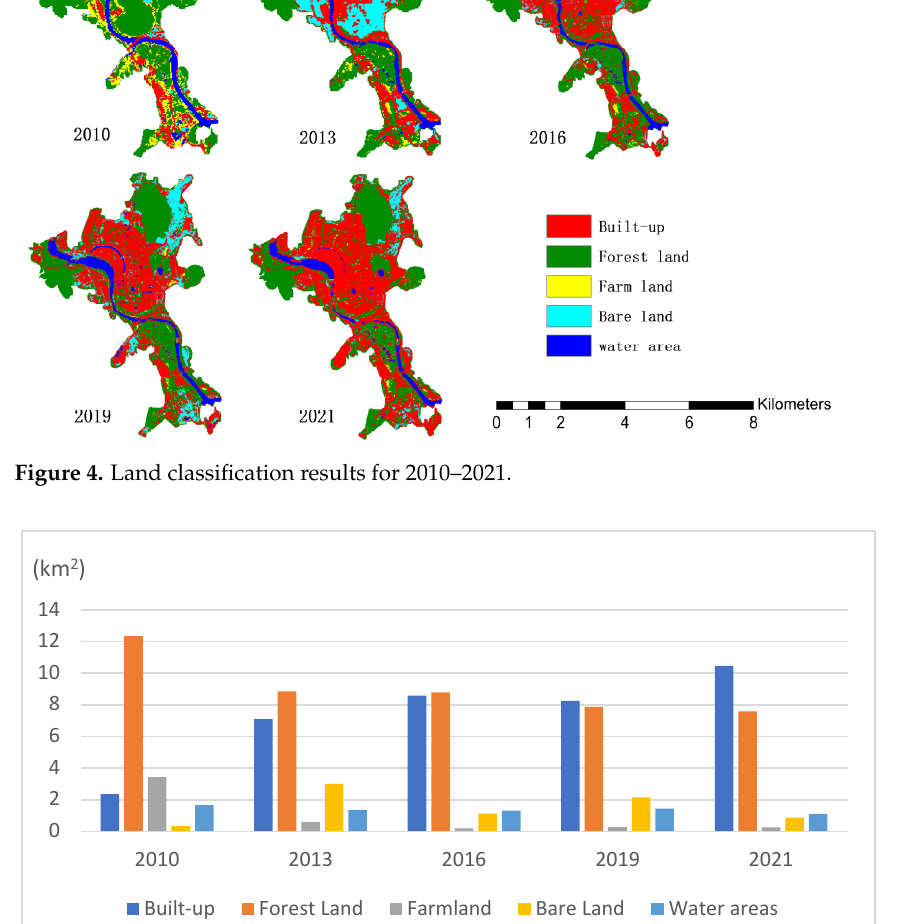
Figure 5. Folded map of land area change.